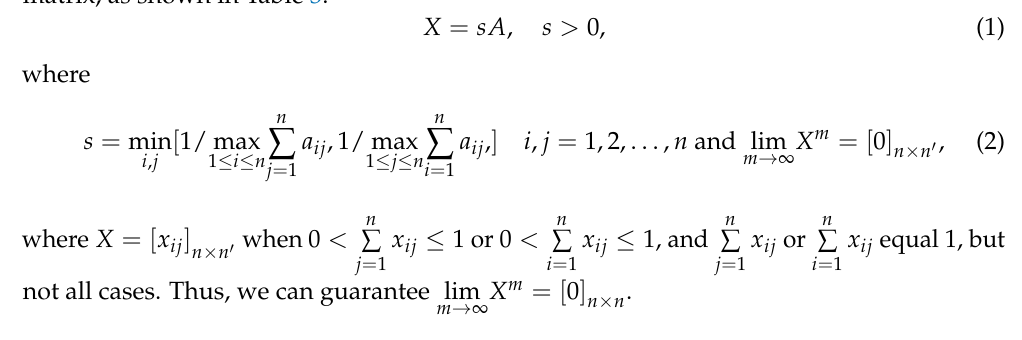
Table 3. The direct influence matrix.